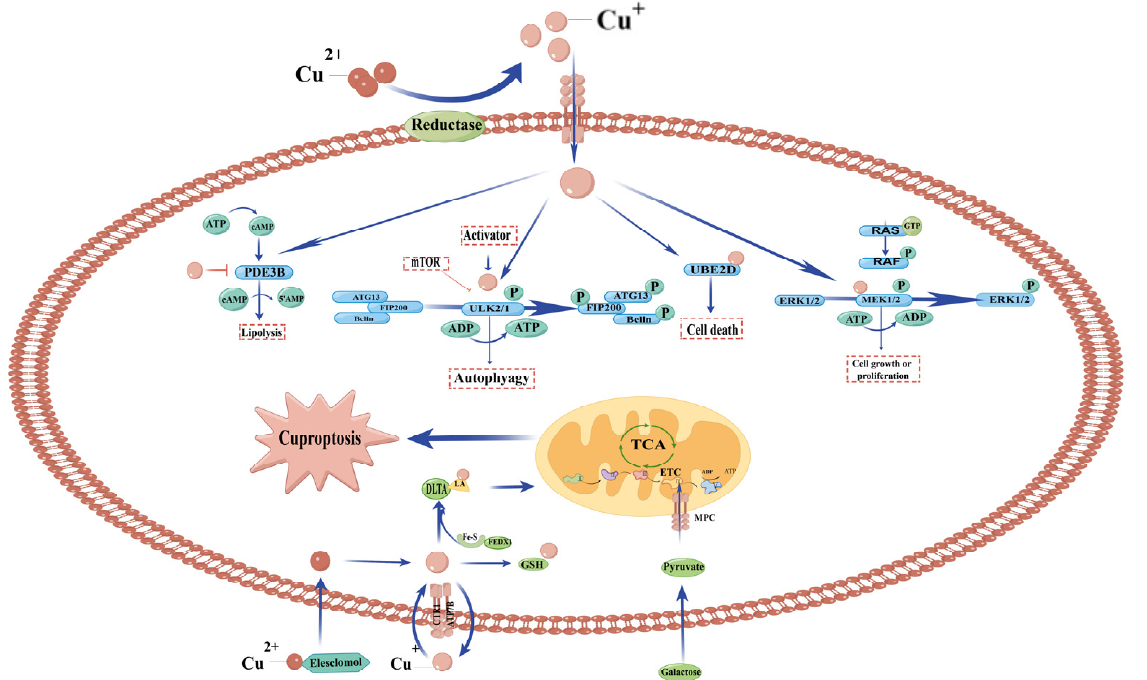
Figure 2. Copper participates in cell death and proliferation pathways. Copper binds to and inhibits Phosphodiesterase 3b (PDE3B), inhibits cyclic AMP (cAMP) degradation, and promotes cAMP-dependent lipolysis, which is needed for fat metabolism. Copper-dependent kinase signalling can regulate autophagy through ULK1 and ULK2. The copper signal promotes protein degradation by binding the E2-binding enzyme UBE2D1-UBE2D4. Copper-dependent kinase signalling can regulate cell growth/proliferation through MEK1 and MEK2. Furthermore copper binds directly to the lipoylated components of the TCA cycle. The accumulation of these copper-bound lipoacylated mitochondrial proteins and the following loss of Fe-S cluster proteins then triggered cuproptosis.